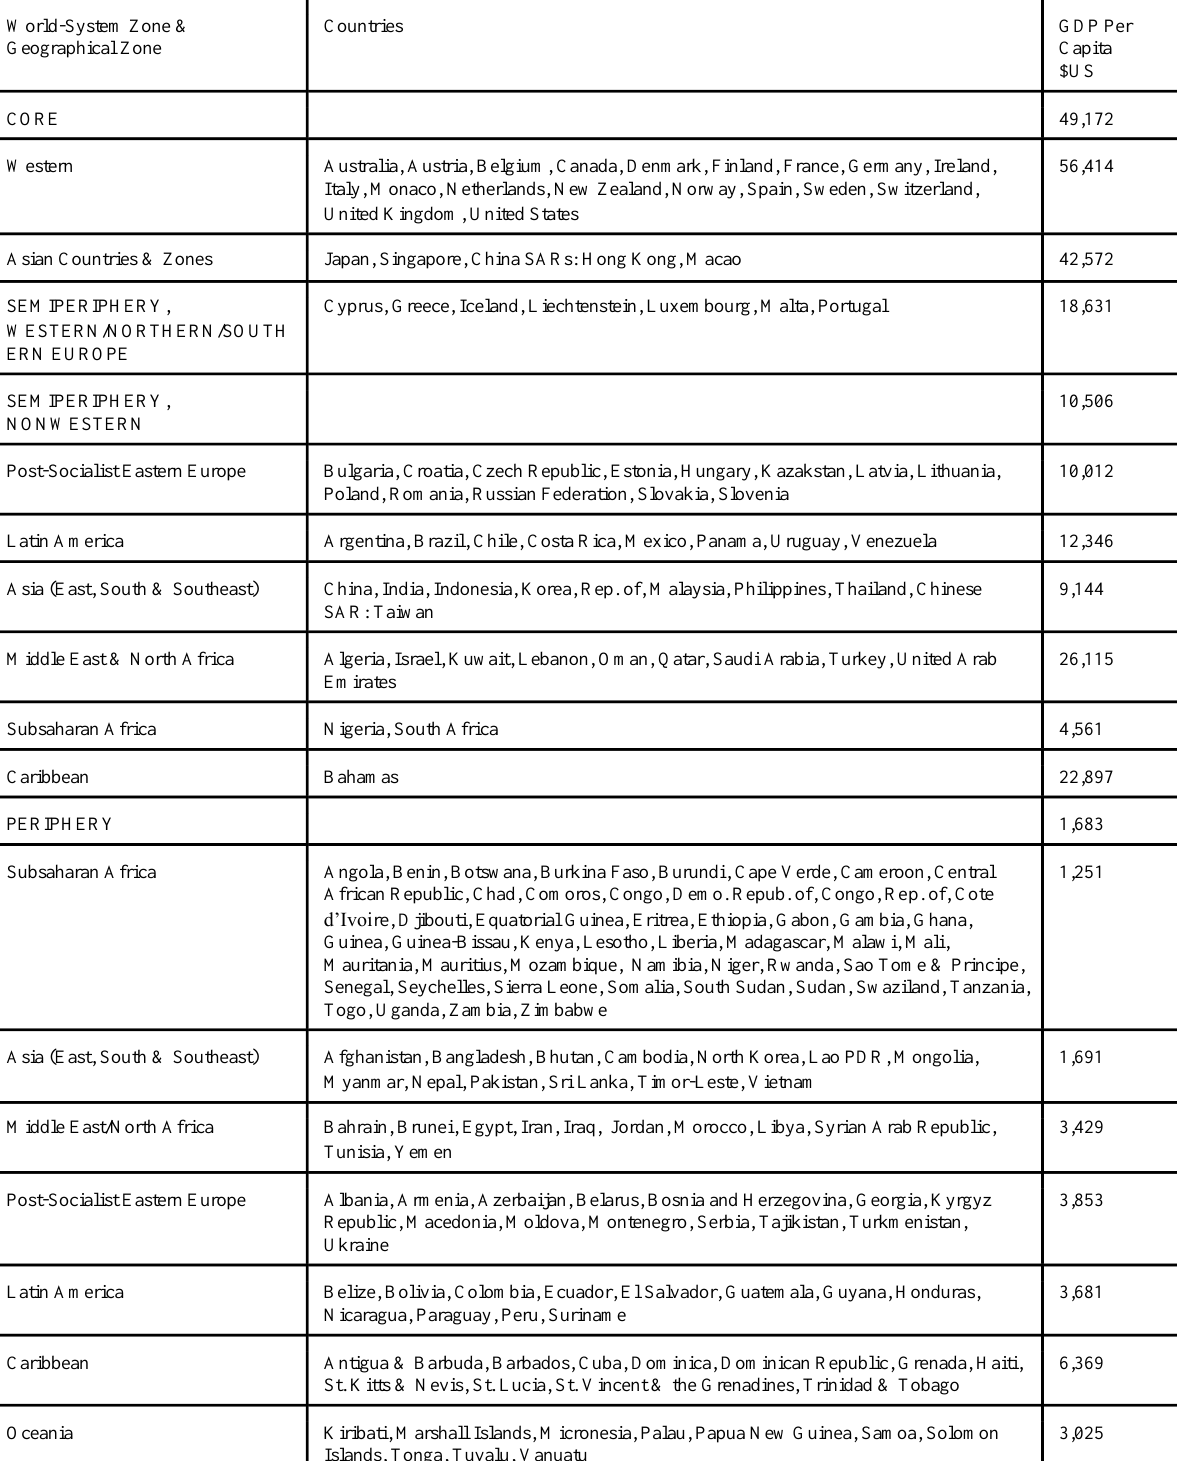
Table 5. The Economic Divides across the Three Tiers of the Modern World-System, 2015 World-System Zone & Geographical